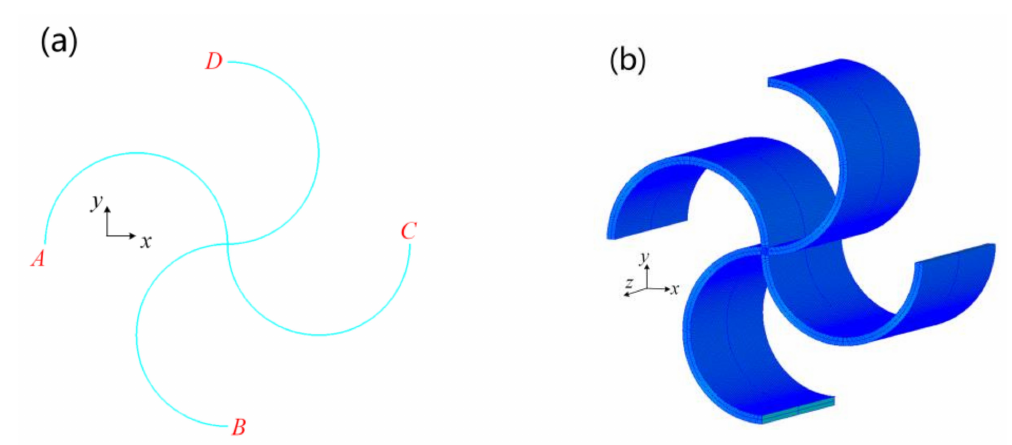
Figure 6. Finite element model: ( a ) 2D curve model and ( b ) 3D